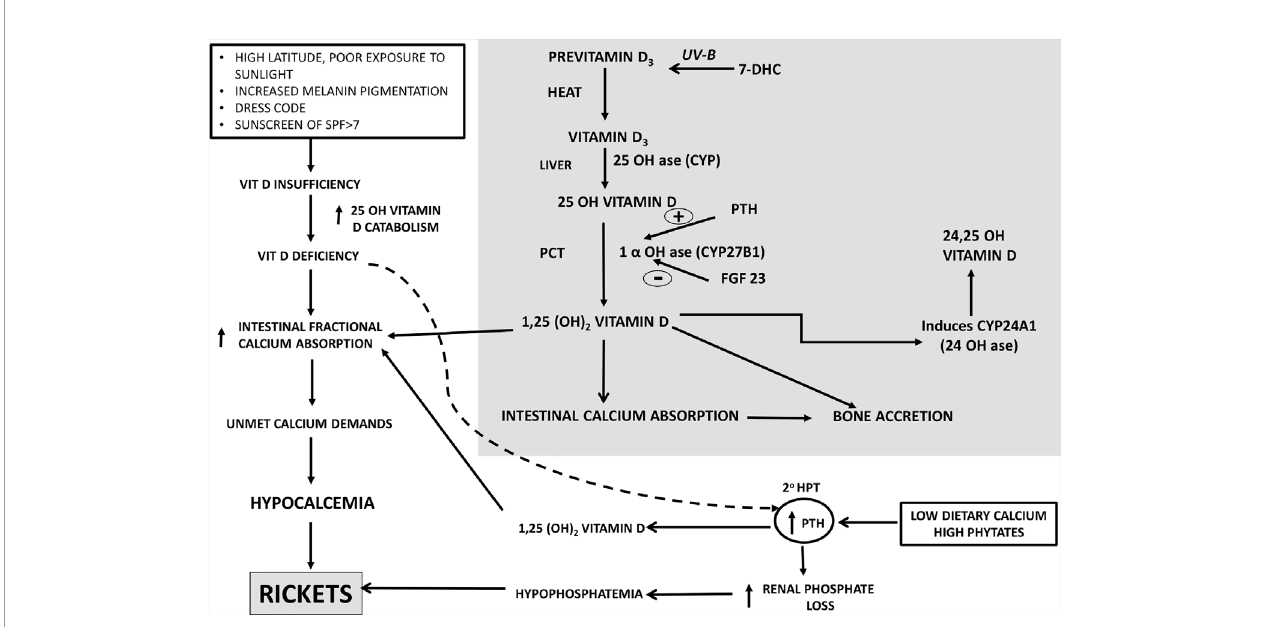
FIGURE 1 | Calcium-Vitamin D-PTH endocrine axis in health during calcium and/or vitamin D deprivation. PTH, Parathyroid Hormone, 2 0 HPT, secondary hyperparathyroidism, SPF, Skin Protection